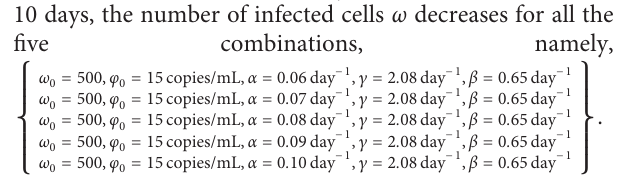
Table 6: The number of infected cells ω for different values of time t and rate of infection α with φ 500 , and c � 2 . 08day − 1 (see Figure 6). Time, t